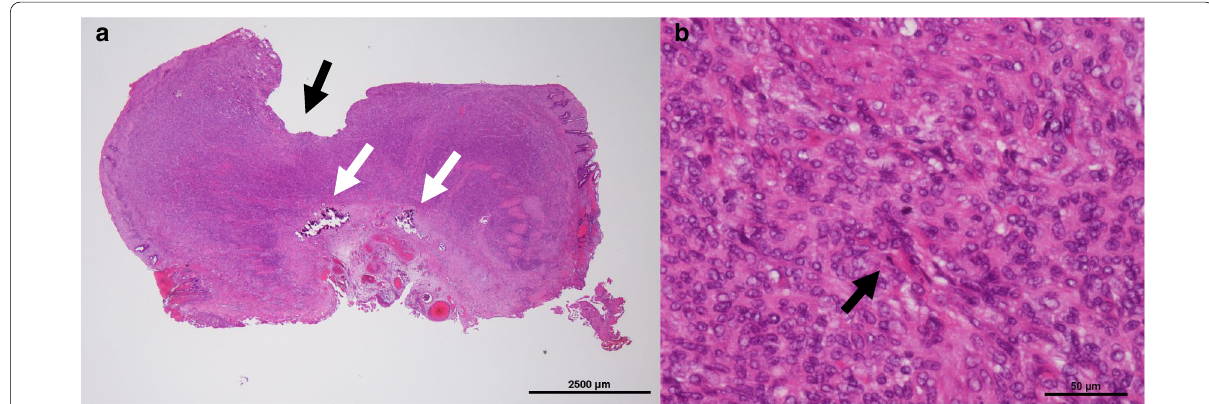
Fig. 3 Hematoxylin and eosin staining. a Tumor cells were proliferating in the submucosal to muscular layers in a generalized manner. The mucosa was also infiltrated by tumor cells and the luminal surface was ulcerated (black arrow). There was partial calcification near the serous layer (white